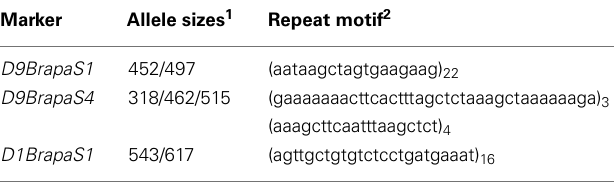
Table 2 | Best RCBrVNTR-type markers for classroom